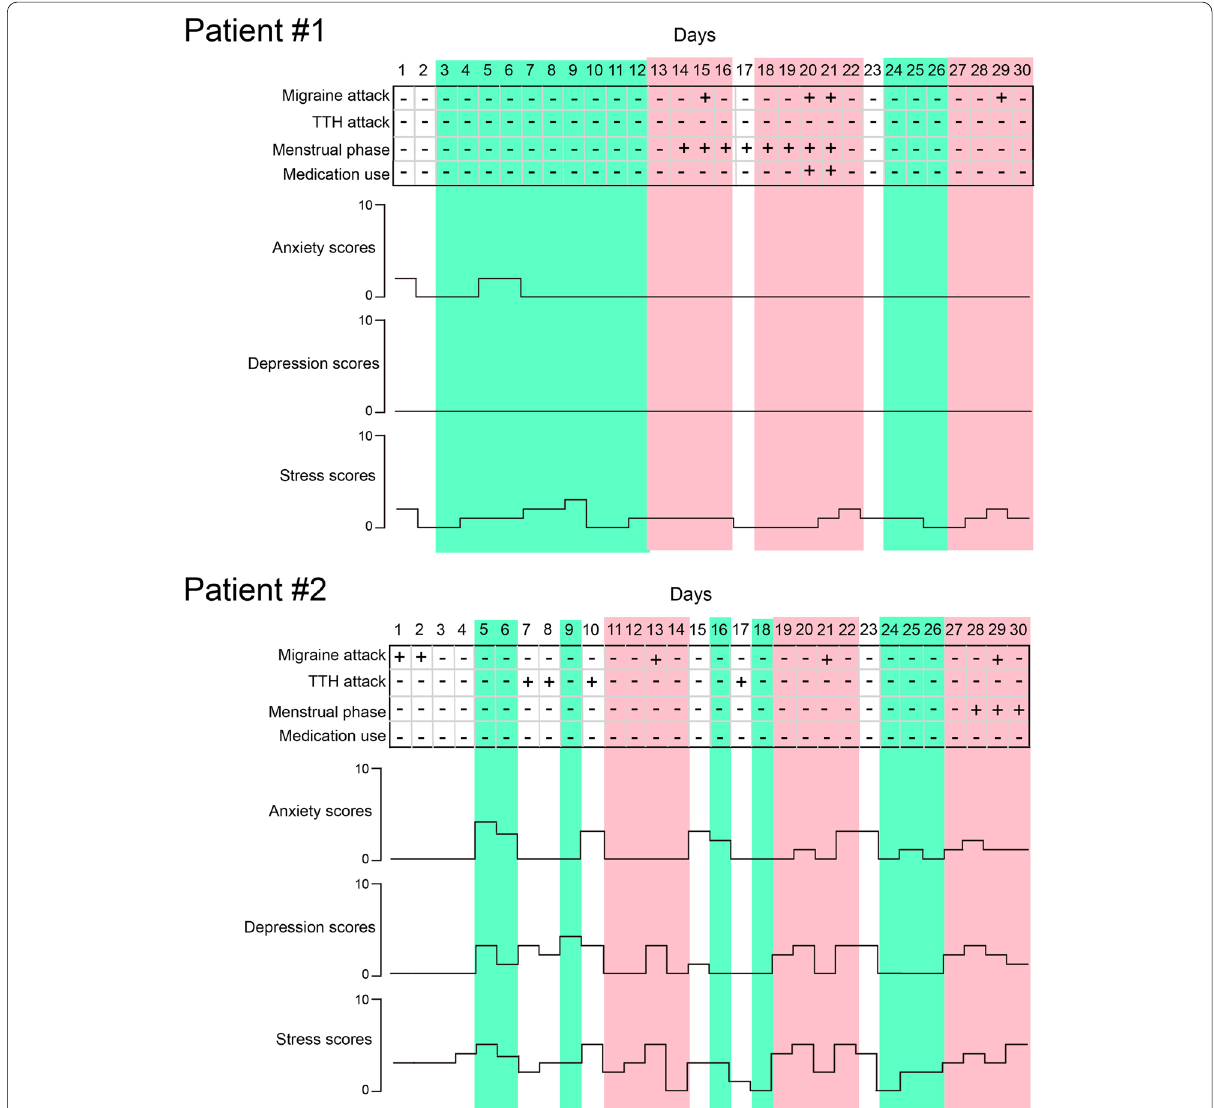
pain‑free interictal period. TTH, tension‑type